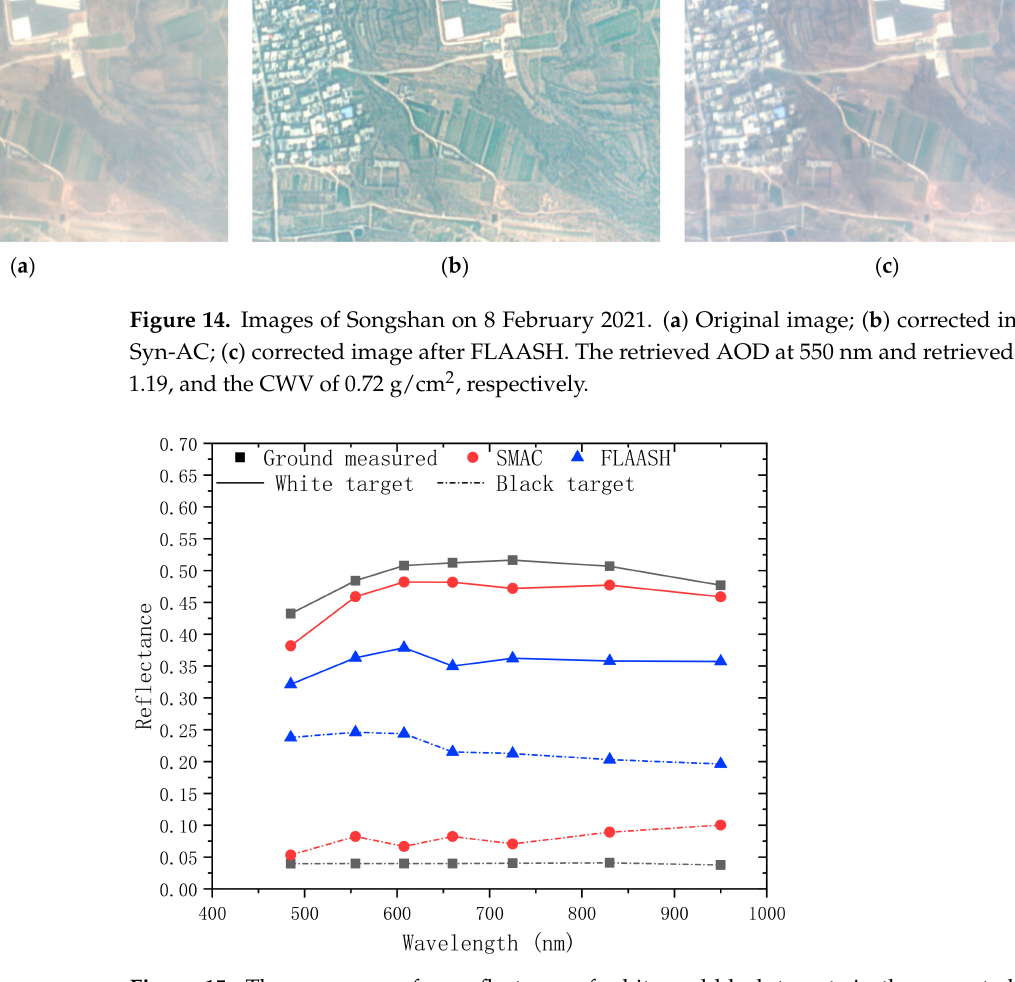
Figure 15. The average surface reflectance of white and black targets in the corrected image of Songshan on 8 February 2021 obtained from Syn-AC and FLAASH and the field-measured